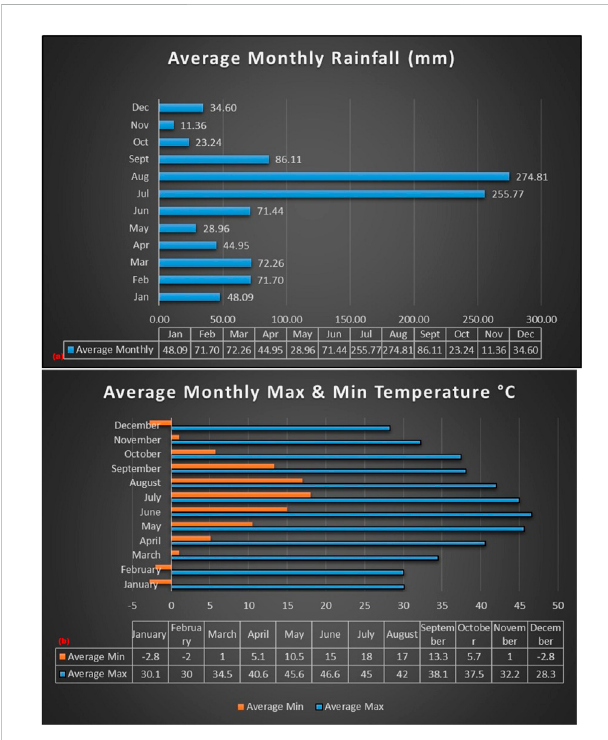
FIGURE 11 (A) Graph generated from the data obtained from the Pakistan Meteorological Department (PMD) showing the average monthly rainfalls for the period 2000 – 2020. (B) Average monthly maximum and minimum temperatures in Islamabad for the period 2000 – 2020.